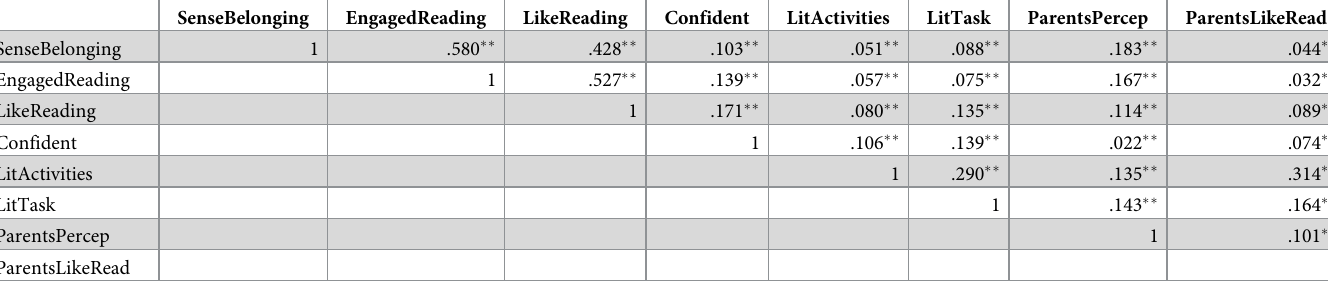
Table 3. Correlations of student and family contextual variables.